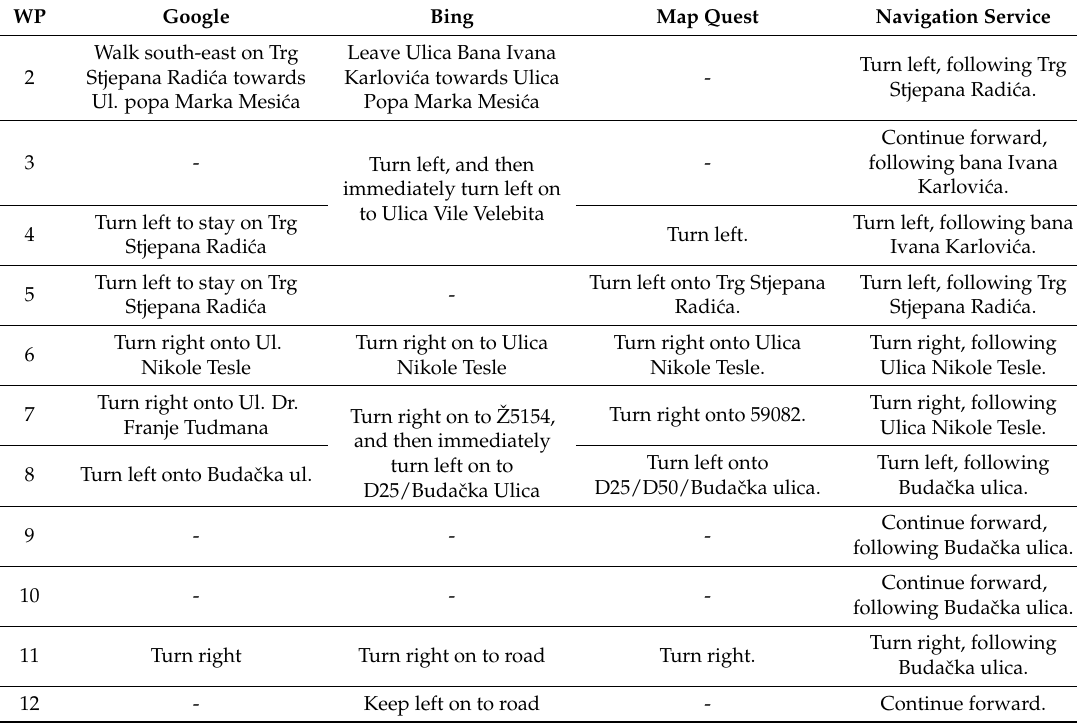
Table 3. Instructions generated for route in Gospi´c,